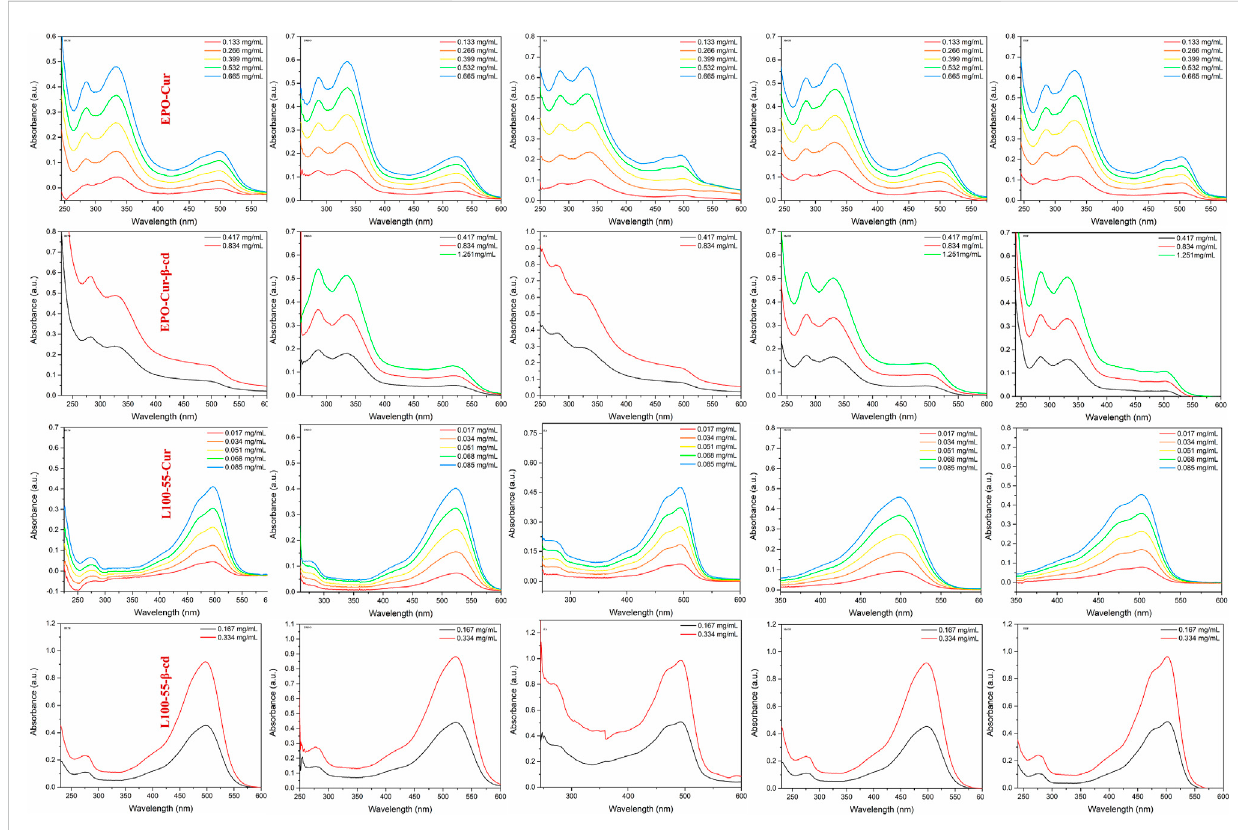
FIGURE 3 UV absorption spectrum of complexes L100-55-Cur, L100-55-Cur- β -cd, EPO-Cur and EPO-Cur- β -cd in different